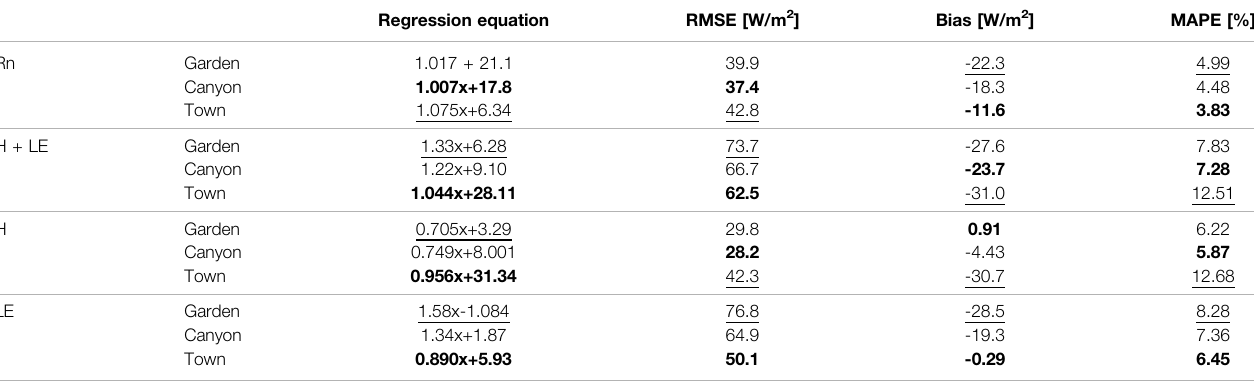
TABLE 4 | Equation of the regression line, Root Mean Square Error (RMSE), Bias, and Mean Absolute Percentage Error (MAPE) between the predicted fl uxes at the garden, canyon,andtownscalesandthemeasured fl uxes.Foreachenergy fl ux,thebestandworstvaluesofthestatisticalindicatorsaccordingtotheoutputscaleareindicated in bold and underlined, respectively.